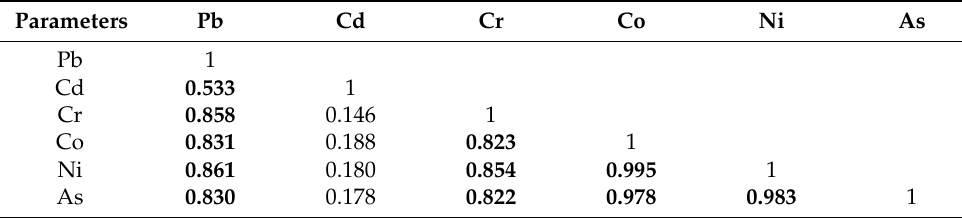
Table 5. Pearson’s correlation among the heavy metal(loid)s.